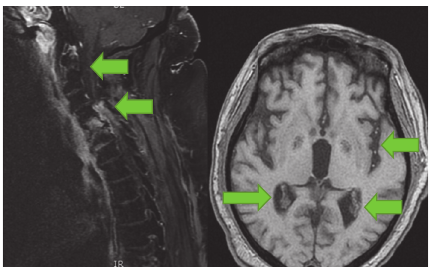
Figure 3: Cephalic and cervical MRI showing septic collections in cerebral ventricles and cervical spinal